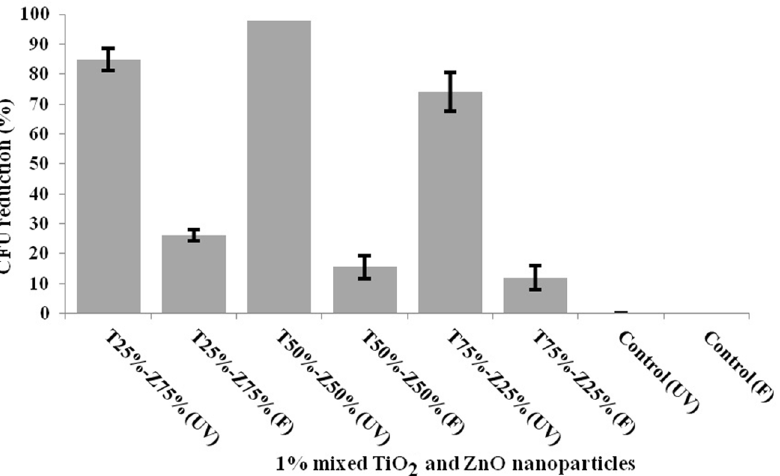
Fig. 7. Bactericidal effects of 1% mixed of TiO presence of fluorescent and UV lights at 4 o